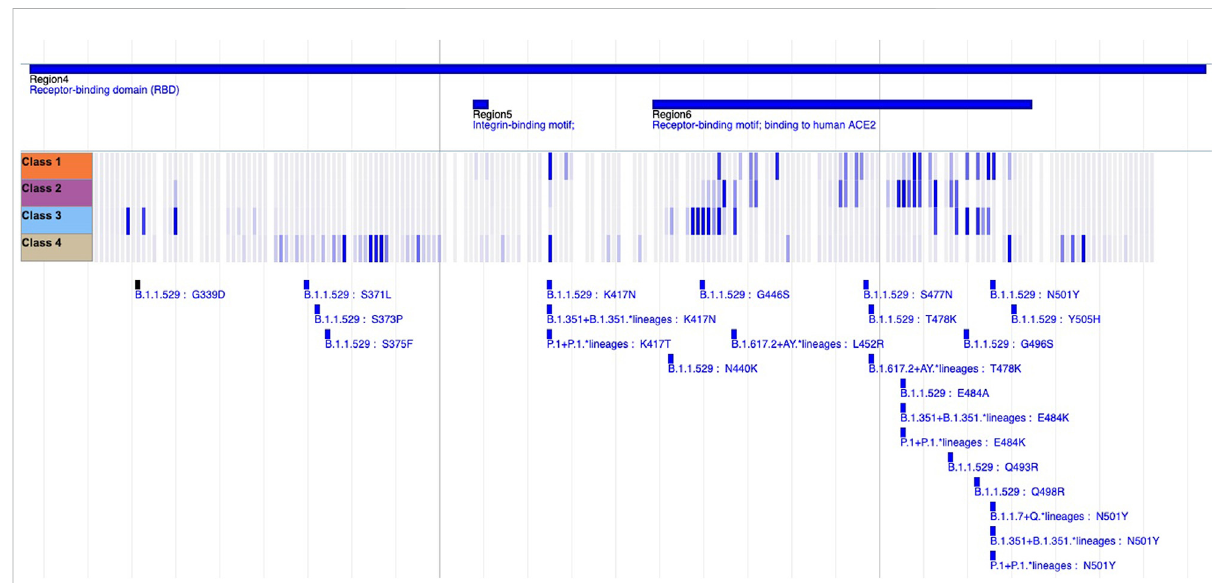
FIGURE 1 Sequence Features of Concern from Deep Mutational Scanning Monoclonal Antibody Escape Data. An image from the BV-BRC SARS-CoV- 2VariantTracker (BV-BRC, 2022)genomebrowser shows aheatmap that quanti fi esthemedian escapefraction for eachmonoclonalantibodyclass (Class 1 — 4 tracks), with thedarker blue indicating greater escape fraction, implying greater loss of antibody binding due to mutations atthat site. We use these quanti fi cations of potential antibody escape per mutated site per antibody class to de fi ne one type of Sequence Feature of Concern. By identifying overlap between variants (bottom tracks) and these monoclonal antibody escape Sequence Features of Concern, the Functional Impact Score of a covariant is